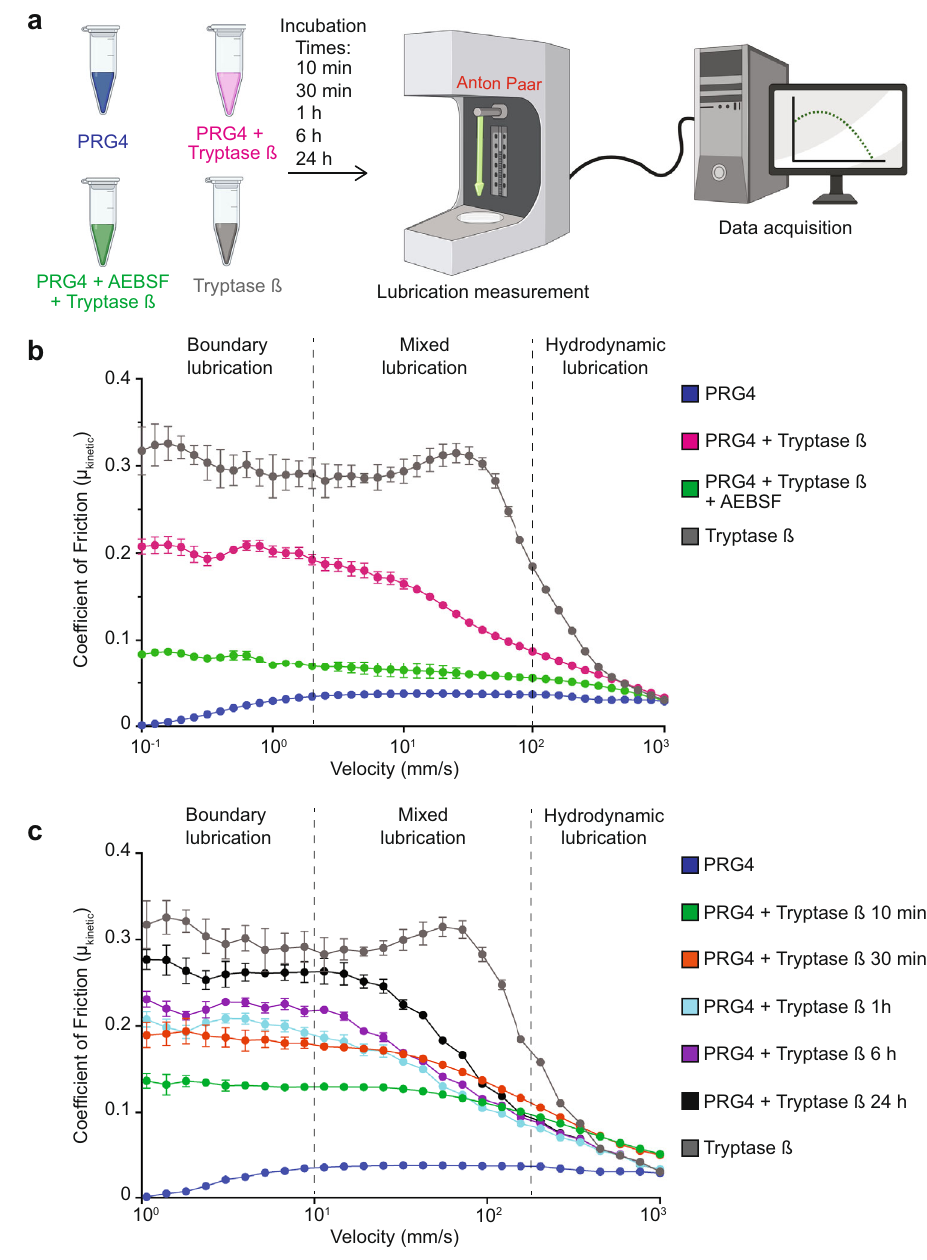
Fig.2|InvestigationofthelubricationofPRG4andtryptase β -processedPRG4. a Schematic of the experimental work fl ow of the lubrication test (created with BioRender). b Lubrication of tryptase β (grey), PRG4 (initial mass of PRG4 1 μ g) (blue), PRG4+tryptase β for 18h (1:100 enzyme/substrate) (magenta), PRG4+ tryptase β + 1mM AEBSF incubated for 18h (1:100 enzyme/substrate) (green). The